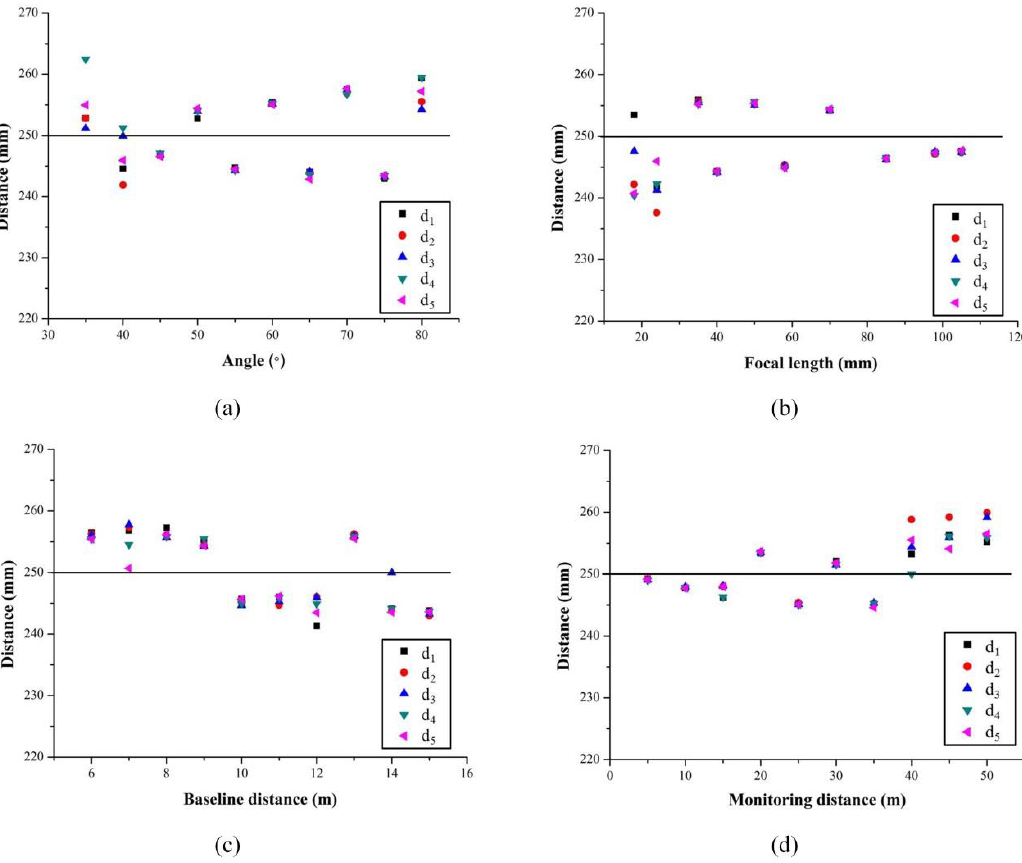
Figure 5. The total displacements measured by binocular vision measurement system with different structure parameters: ( a ) the angle α between optical axis and baseline; ( b ) focal length f ; ( c ) baseline distance B ; ( d ) monitoring distance Z .